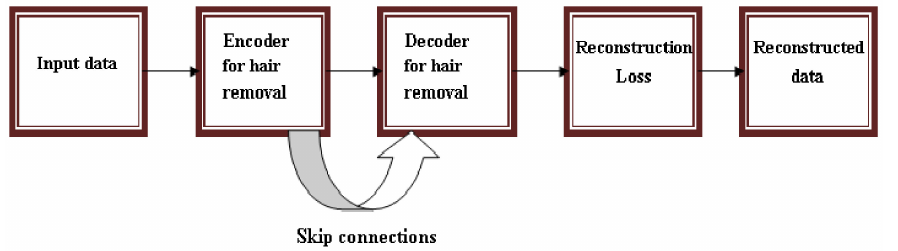
Figure 24. The schematic architecture of the proposed system for hair removal from skin lesion images from [117].